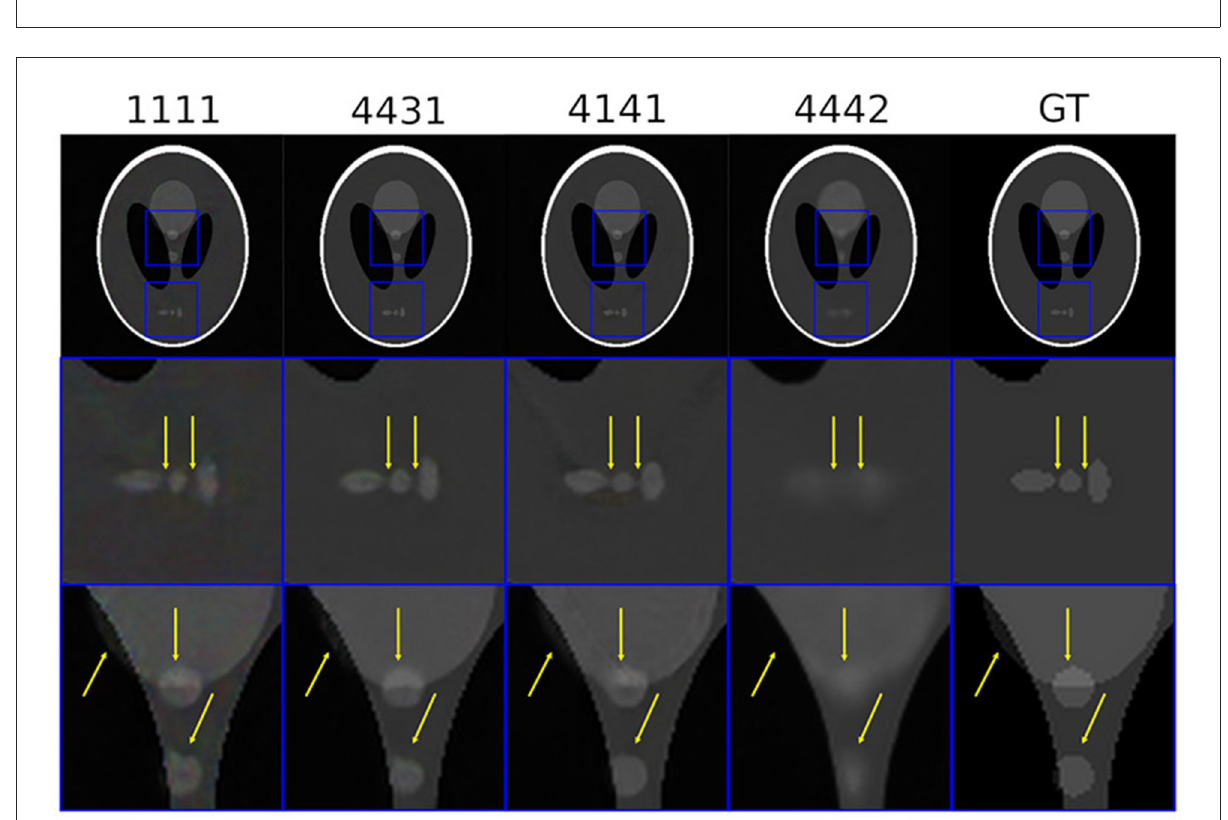
FIGURE10 Phantom experiments in the version 512